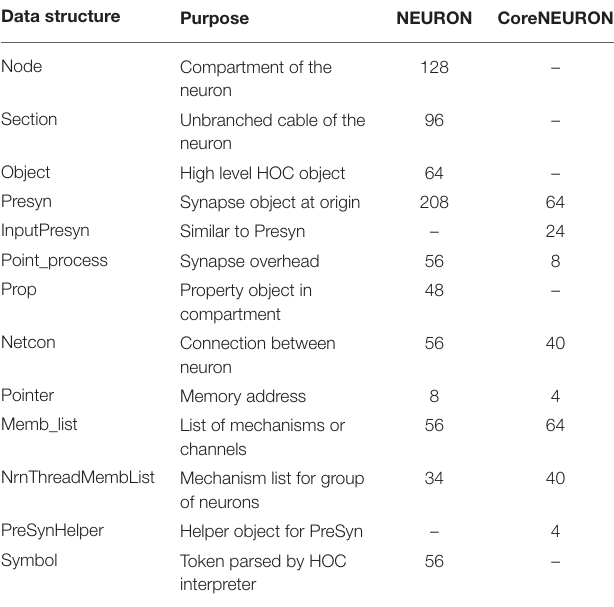
TABLE 2 | Memory footprint comparison for different data structures (in